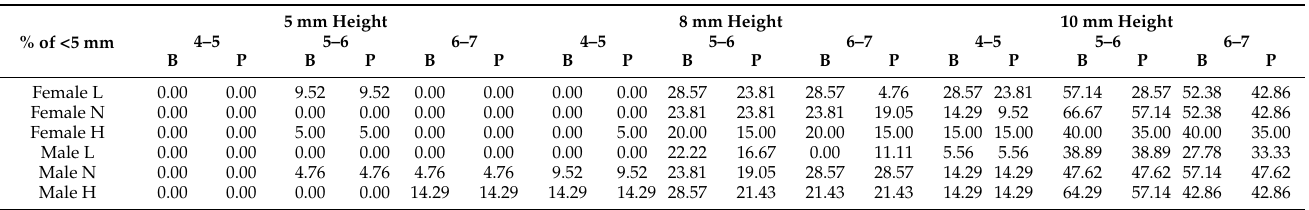
Table 8. The chance of alveolar bone thickness of less than 5 mm in each location measured in the skeletal class I population. L: low-angle; N: normo-angle; H: high-angle. 4: first premolar, 5: second premolar, 6: first molar, 7: second